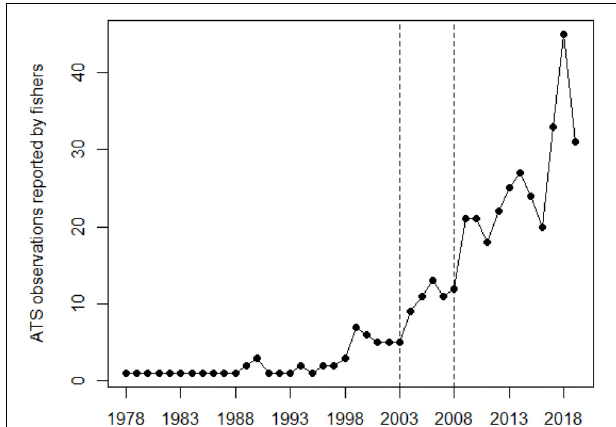
FIGURE 6 | Occurrence of Abnormally Tough Specimen (ATS) observations over time, summing the number of ATS observations reported by fishers on a yearly basis. Vertical dashed lines mark the years when organotin compounds in anti-fouling paints were no longer allowed and copper-based started to be used on vessels and mariculture cages (2003), and when the EU banned the entry of vessels carrying paints with organotin compounds